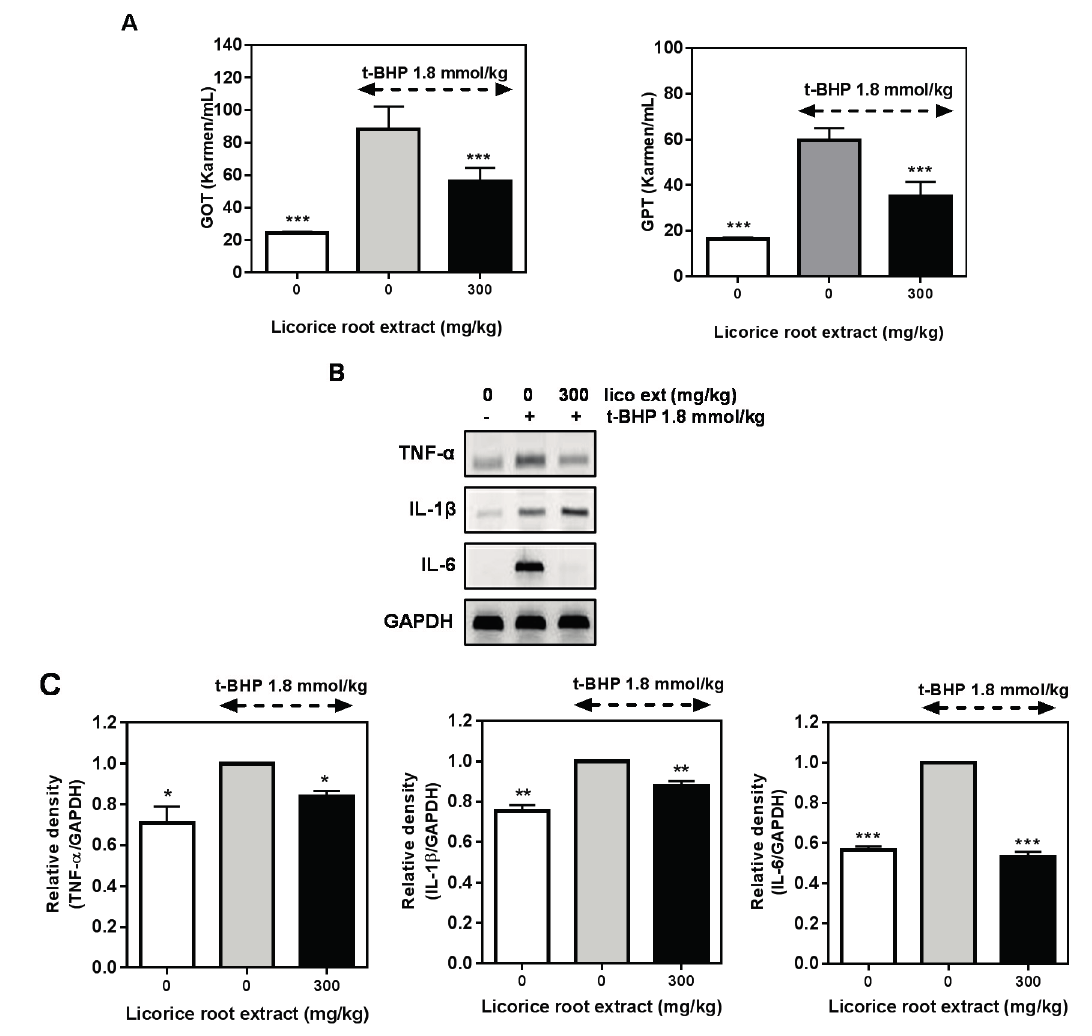
Figure 5. Hepatoprotective effect of licorice extract on the tert -butyl hydrogen peroxide ( t -BHP)-induced liver damage in mice. ( A ) Plasma levels of the hepatic enzymes ALT and AST were determined using appropriate kits after t -BHP treatment for 24 h; ( B ) Animals were pre-treated with licorice extract for three days. The mice were administered t -BHP intraperitoneally on Day 4. After 24 h, the animals were euthanized by heart perfusion with saline, and the liver tissue was obtained. The levels of pro-inflammatory cytokines on liver tissue were determined by quantitative PCR; ( C ) Each pro-inflammatory cytokine expression was analyzed by using the relative density of GAPDH. The results are the means ± SD of three separate experiments. * p < 0.05, ** p < 0.01, *** p < 0.001 compared to the t -BHP only-treated